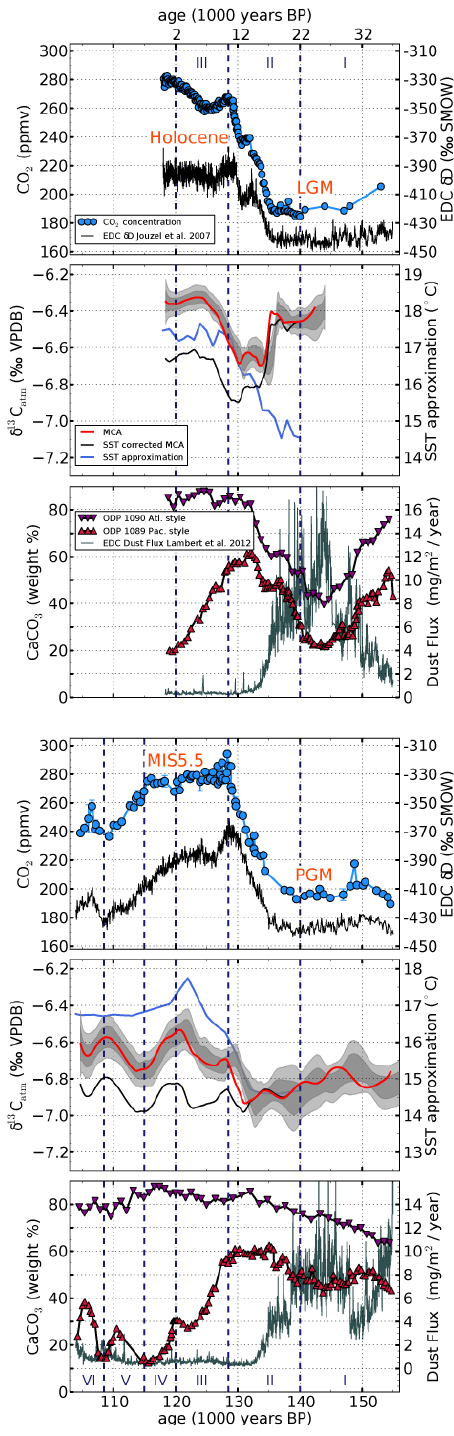
Fig. 2. Comparison of carbon cycle changes around Termination I and II: the top panels show from top to bottom: CO 2 (blue circles, Monnin et al., 2001) and δD (black line, Jouzel et al., 2007), the δ 13 C atm MCA (red line, Schmitt et al., 2012) as well as a SST-corrected version (black line) according to a global SST reconstruction, which is based on the sea-ice-free surface ocean only (light blue line) (Köhler and Fischer, 2006), CaCO 3 weight percent content of sediment cores ODP1089 (red upward pointing triangles) and ODP1090 (magenta downward pointing triangles) (Hodell et al., 2001) as well as the dust flux reconstructed from the EDC ice core (grey line) (Lambert et al., 2012) for the last 24000yr. Ice core data are given on the EDC3/TALDICE-1a age scale, while marine CaCO 3 reconstructions are given on their individual age scales. In the lower panels, the same species are plotted for the time between 155000–105000yrBP. CO 2 (blue circles), the δ 13 C atm MCA (red line), and SST-corrected δ 13 C atm MCA (black line) are from this study. Uncertainty ranges for the δ 13 C atm MCAs represent the one σ and two σ confidence intervals (compare Fig. 1 for further explanation). Plotted data are aligned for coinciding CO 2 maxima at the end of Termination I and II. The LGM, here defined as 22000yrBP (Clark et al., 2009), is aligned to the PGM time slice, here defined as the temperature minimum at 140000yrBP. Data are subdivided into the same time periods as in Fig.